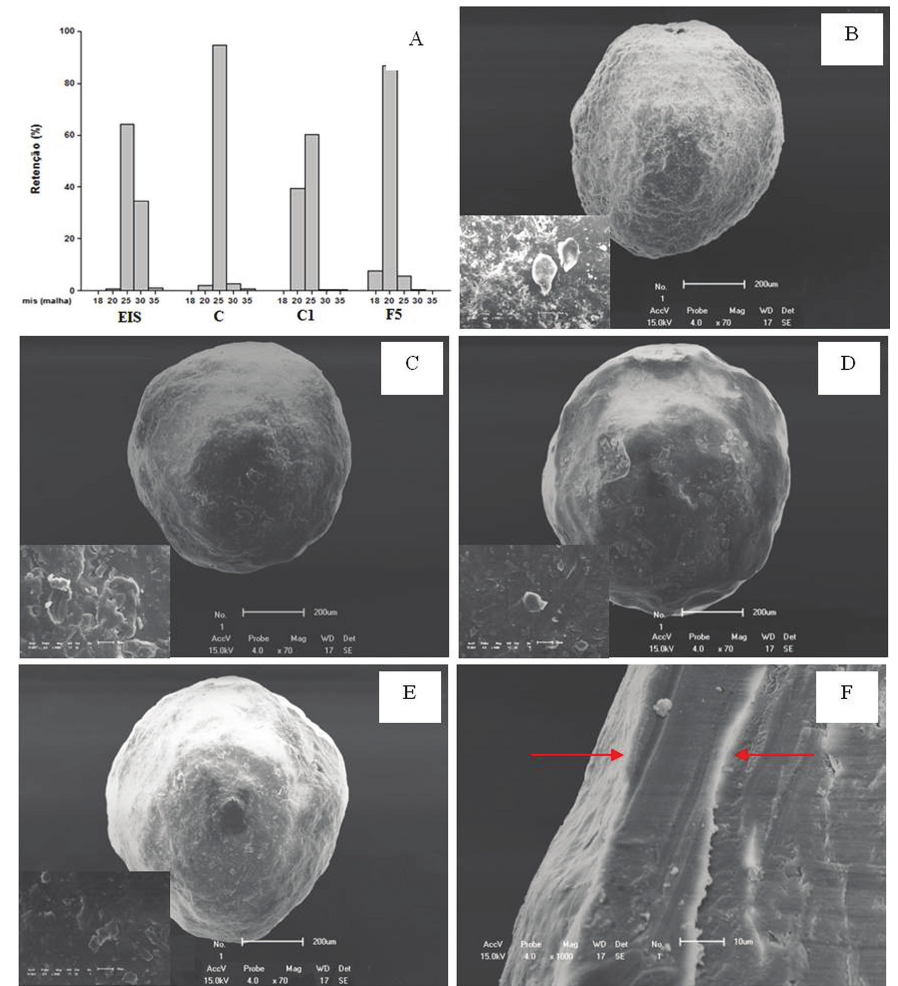
FIGURE 7 - Granulometric and external morphology analysis of pellets A) Granulometric analysis of the EIS and the pellets coated C, C1 and F5; B) Evaluation of the external morphology of the EIS in increase of 70x and 1000x; C) Evaluation of external morphology of C in increase of 70x and 1000x; D) External morphology evaluation of C1 in increase of 70x and 1000x; E) External morphology evaluation of F5 in increase of 70x and 1000x; F) Transversal image of F5 in increase of 1000x with emphasis in the coating layer of the